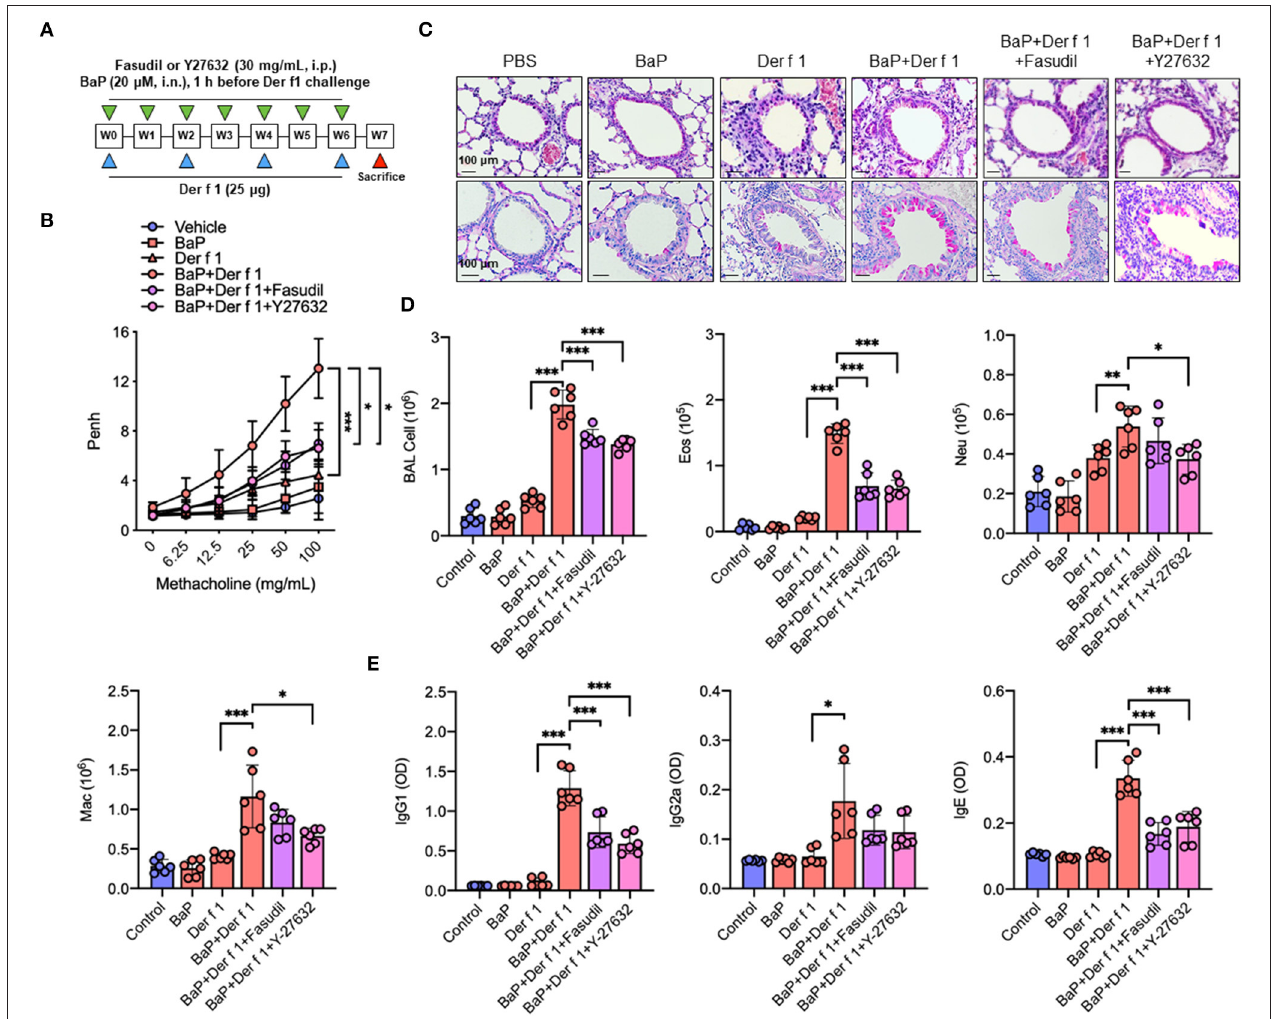
FIGURE 6 | Inhibition of RhoA suppresses BaP co-exposure-induced AHR and Th2-associated airway inflammation. (A) Protocol for BaP (20 µ M) and Der f 1 (25 µ g) co-exposure-induced mouse model of asthma in the presence or absence of Fasudil or Y-27632 (30 mg/ml, i.p.). (B) Lung resistance in response to increasing concentrations of methacholine using the forced oscillation technique (FlexiVent, SCIREQ). (C) Histological examination of mouse paraffin lung sections stained with hematoxylin and eosin (upper panel) and periodic acid–Schiff (lower panel). (D) Bronchoalveolar lavage fluid total and differential (eosinophil, neutrophil,